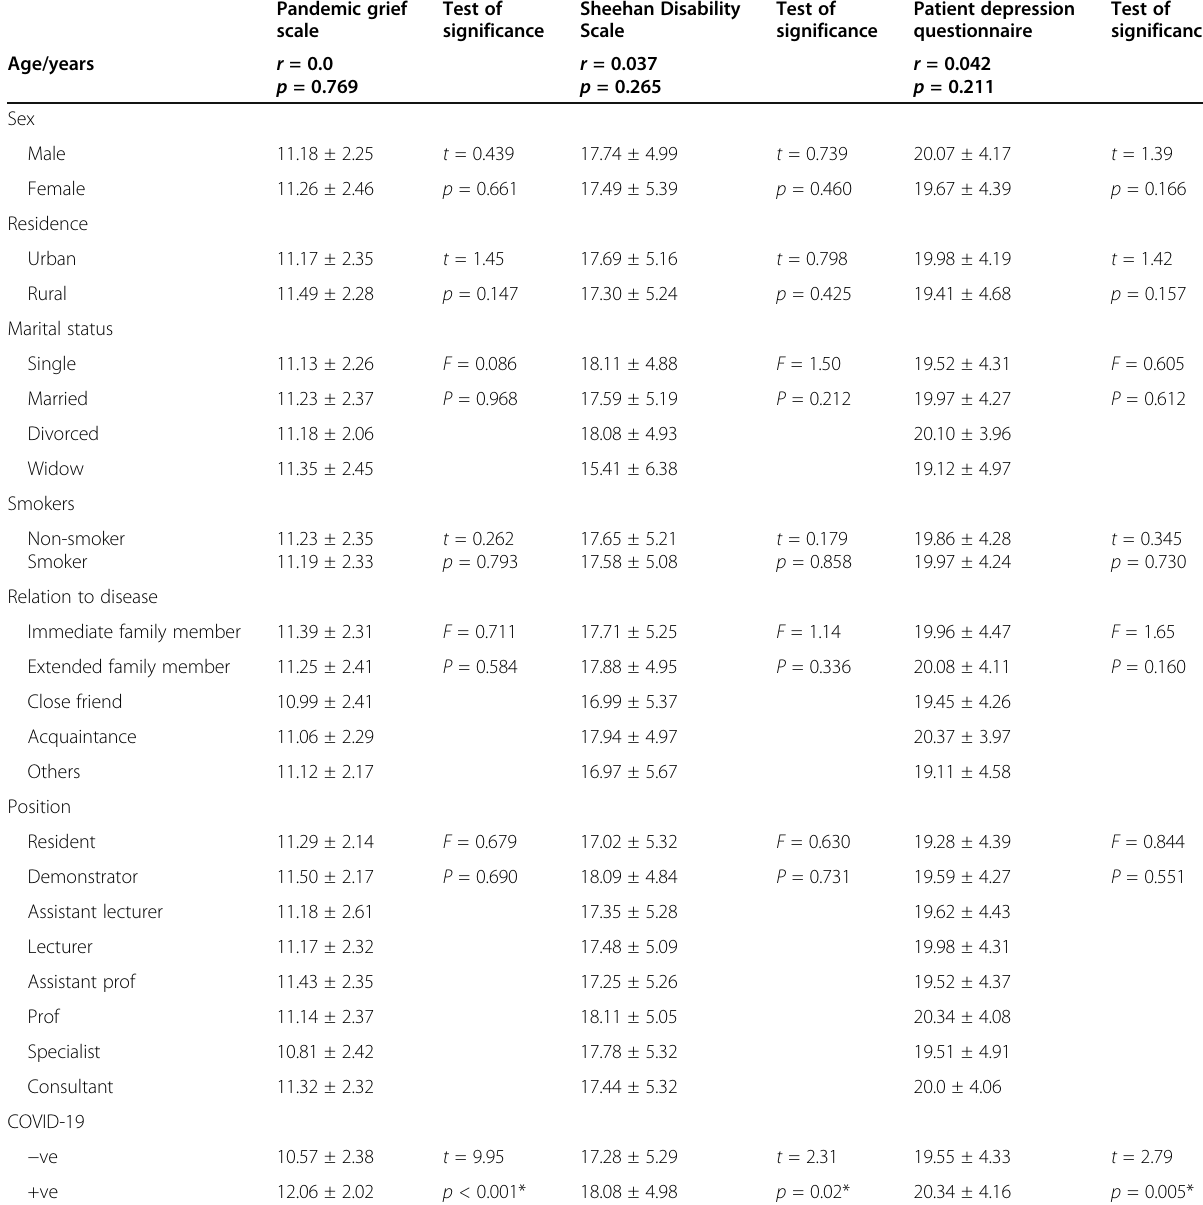
Table 3 Factors affecting Sheehan Disability Scale, Pandemic Grief Scale, and Patient Health Depression Questionnaire-9 among studied